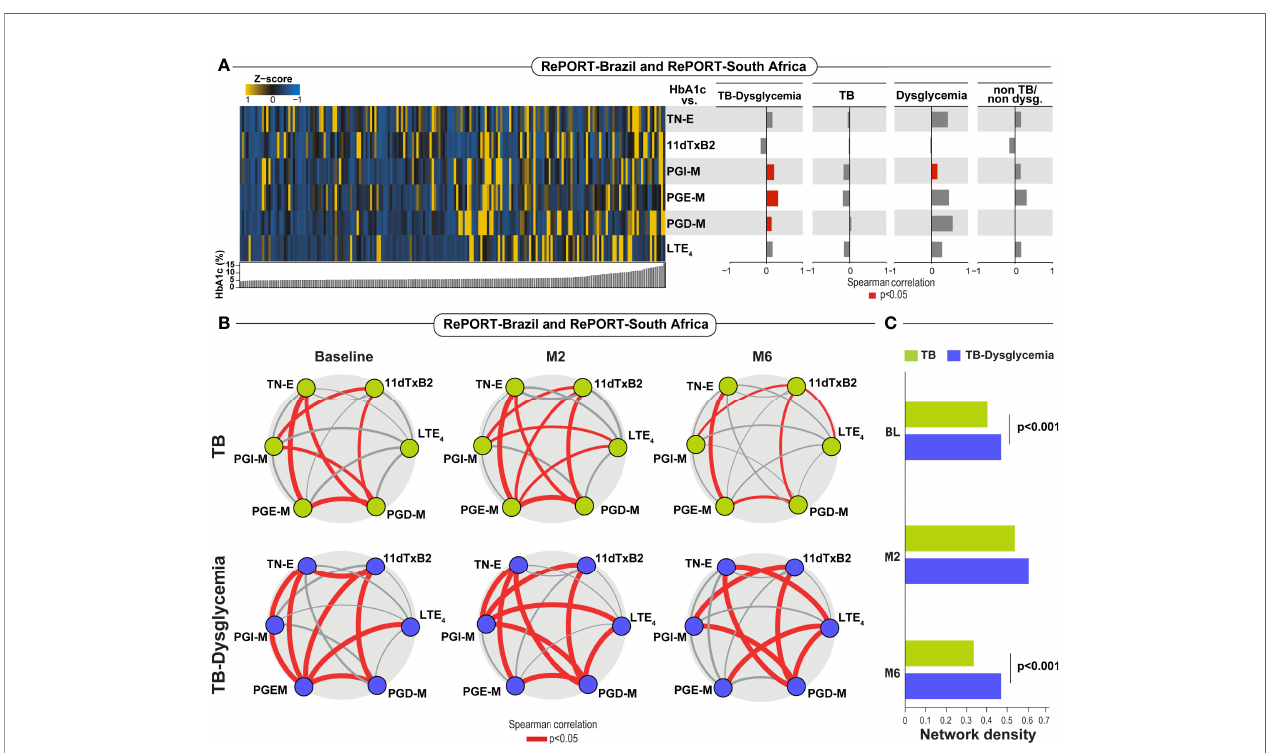
FIGURE 3 | (A) Spearman correlation analysis plots between HbA1c (%) and TB-dysglycemia, TB, dysglycemic patients and non-TB/non-dysglycemia individuals at baseline. Signi fi cant correlations (p< 0.05) are represented in red bars. (B) Network analysis of eicosanoids in TB and TB-dysglycemic patients in the baseline, month 2 (M2) and month 6 (M6) among patient from Brazil and South Africa. Red solid lines: positive signi fi cant correlations (Spearman correlation). (C) Network densities of each bootstrap were calculated for each study group and timepoint as described in Methods. TB, tuberculosis; Dys, dysglycemia; PGE-M, major urinary PGE 2 metabolite; PGD-M, major urinary PGD 2 metabolite; PGIõ-M, 2,3-dinor-6-keto-PGF 1 a (PGI 2 Metabolite); 11dTxB2, 11-dehydro-thromboxane B 2 (TxB 2 urinary metabolite); TN-E, tetranor-PGE 1 (urinary PGE 2 metabolite); LTE 4 , Leukotriene E 4